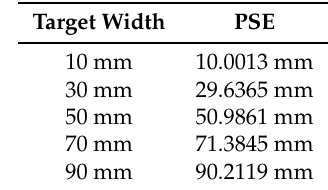
Table 3. Mean widths in mm for width judgement task.